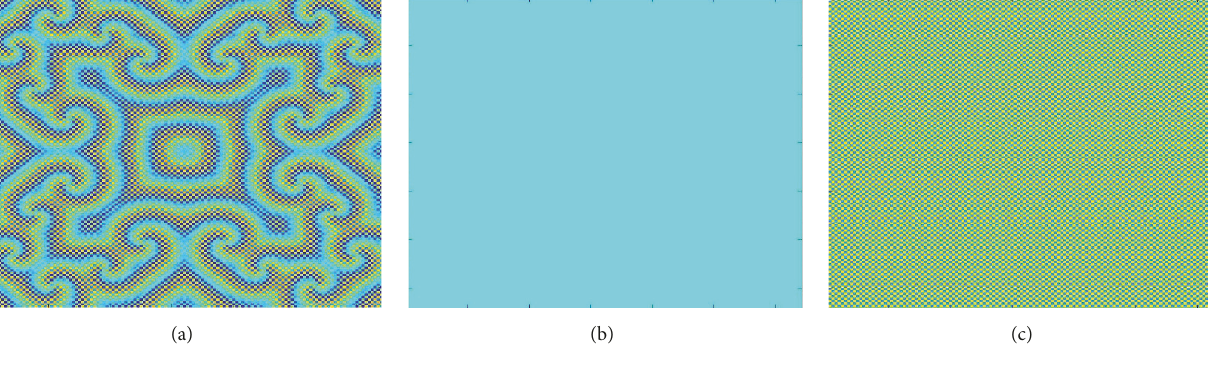
Figure 2: Selective patterns resulting from different parameters values and fixed initial value when 𝑡 = 50000 . (a) 𝑟 = 2.98, 𝑎 = 0.5, 𝐷 = 0.1. (b) 𝑟 = 2.9892, 𝑎 = 0.6735, 𝐷 = 0.0906. (c) 𝑟 = 2.9710, 𝑎 = 0.5201, 𝐷 = 0.0924.